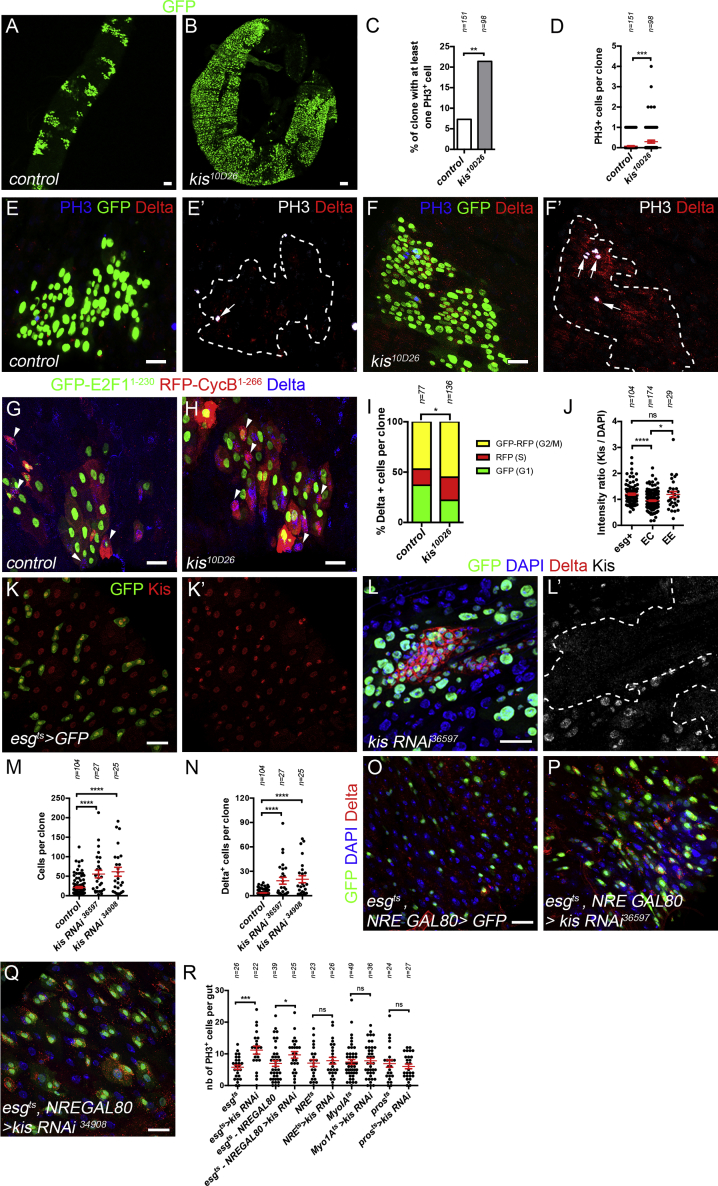
Loss of kismet Activity Promotes ISC Proliferation(A and B) Wild-type (A) and kis10D26 (B), MARCM clones at 30 days AHS.(C and D) Quantification of the percent of clones with at least one PH3+ cell (C) and the average number of PH3+ cell per clone (D) from (E)–(F′).(E–F′) Wild-type (E and E′), and kis10D26 (F and F′), 9 days AHS MARCM clones (arrows show PH3+ cells).(G and H) Wild-type (G) and kis10D26 (H), MARCM clones 9 days AHS expressing UAS-GFP-E2f1-230, UAS-mRFP-CycB1-266 FUCCI system allowing cell cycle stage determination (G1, nuclear GFP+; S: RFP+; and G2/M, GFP+ and RFP+; arrowheads show Delta+ ISCs).(I) Quantification of the percent ISCs (from G and H).(J) Mean Kismet fluorescence intensity normalized by mean DAPI staining in ISCs (esg+), EEs (diploid esg−), and ECs (polyploid cells) from (K) and (K′).(K and K′) Kismet showed ubiquitous nuclear expression with a stronger accumulation in esg+ progenitor cells (ISCs and EBs) marked by GFP and EE cells (diploid GFP−).(L and L′) kismet RNAi-expressing clones, 9 days AHS, had depleted Kismet protein and reproduced kis10D26 phenotypes.(M and N) Quantification of the number of cells per clone (M) and ISCs (Delta+) per clone (N) in wild-type and kis RNAis expressing clones.(O–Q) ISC-specific expression of GFP alone (O) or with kis RNAi BL36597 (P) or with kis RNAi BL34908 (Q) for 10 days at 29°C using esgts- NRE-GAL80 driver.(R) Quantification of the number of PH3+ cells per posterior midgut expressing kis RNAi in the ISCs and EBs (esgts driver), in ISCs only (esgts- NRE-GAL80 driver), in EBs only (NREts), in ECs only (Myo1Ats) for 10 days, or in EE cells (prosts) for 10 days.A Fisher’s exact test was used in (C). A two-tailed Mann-Whitney test was used in (D), (J), (M), (N), and (R). A χ2 test was used for (I). Mean values in red; error bars, SEM; ns = non-significant, *p < 0.05, **p < 0.01, ***p < 0.001, ****p < 0.0001. Scale bars, 20 μm.